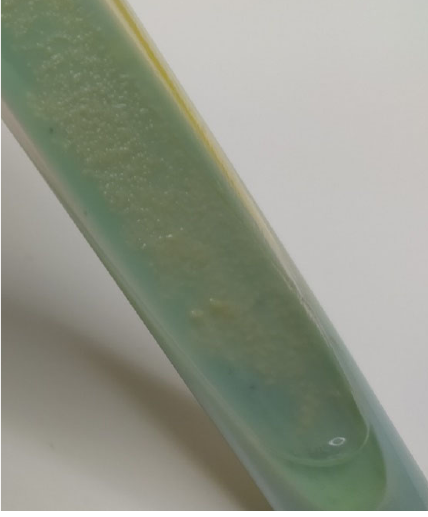
Figure 1. MKC growth on Petragnani medium. Table 2. Reaction components. Table 1. Starter sequences used in the reaction.